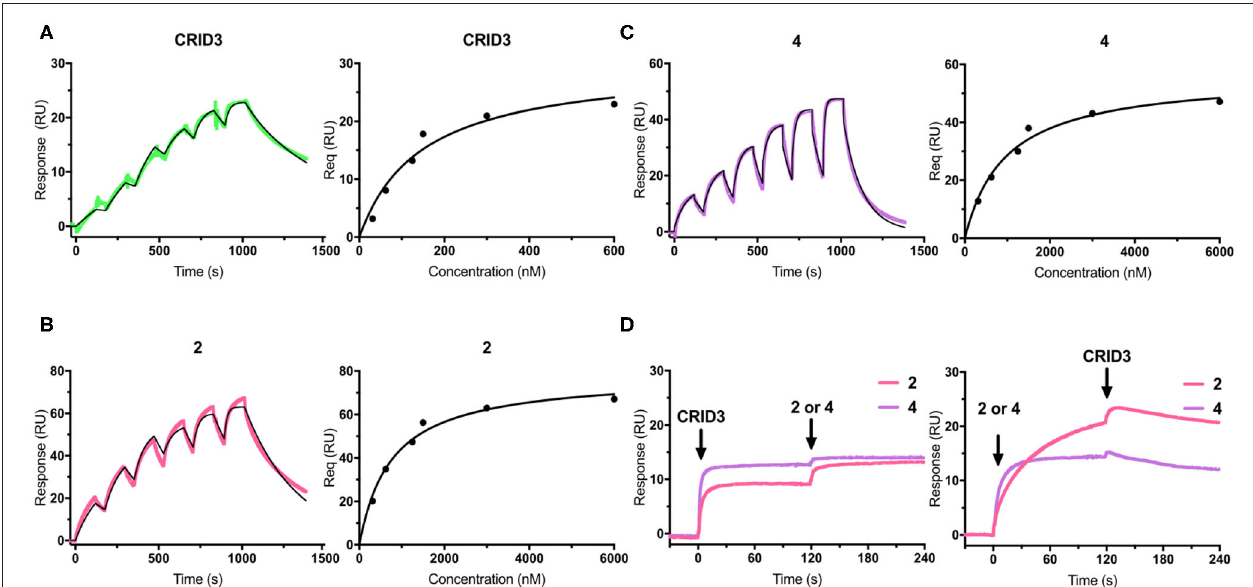
FIGURE 3 | (A – C) SPR sensorgrams (left) and concentration-binding response unit curves (right) of CRID3/MCC950 (A) , compound 2 (B) , and compound 4 (C) injected on the chip surface loaded with human NLRP3-PYD-NACHT. The binding parameters obtained from the sensorgrams are listed in Table 1 . Data were fitted to a 1:1 binding model. (D) SPR sensorgrams of CRID3/MCC950, compound 2 , and compound 4 injected in competition mode on the chip surface loaded with human NLRP3-PYD-NACHT. Either CRID3/MCC950 (left) or compound 2 or 4 (right) were provided in the first injection step, followed by a second injection step after 120s, where equimolar concentrations of the second compound were injected in presence of the first compound.